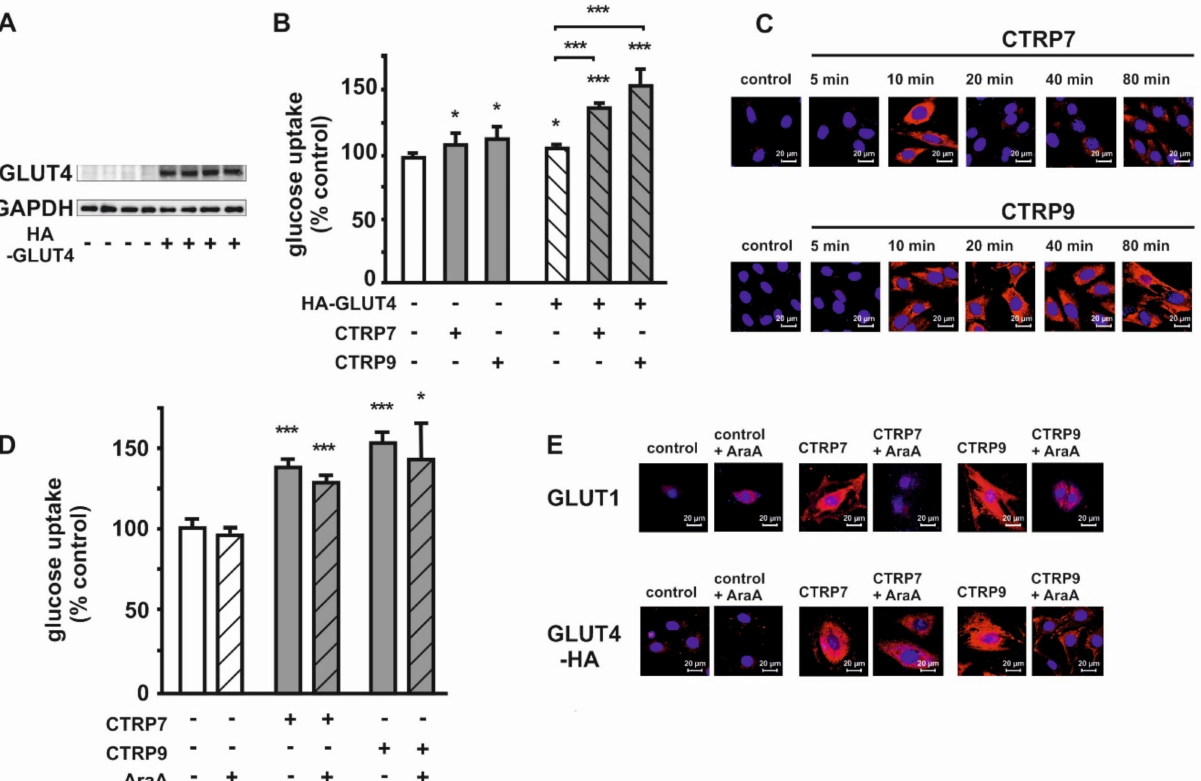
Figure 8. Effects of CTRP7 and CTRP9 on glucose uptake in GLUT4-overexpressing H9C2 cardiomyoblasts. ( A ) Western Blot identification of GLUT4 expression following GLUT4 overexpression compared to basal GLUT4 expression in H9C2 cells. GAPDH served as loading control. ( B ) Following glucose starving for 3 h in DMEM without glucose and serum, cells were treated with CTRPs in serum-free DMEM containing 2-[ 14 C] DG for 1 h. Value was normalized to protein concentration. Data are from 5 independent experiments with 3 biological replicates, each, and are represented as mean ± SEM. * p < 0.05, *** p < 0.001 vs. control, unless otherwise indicated. ( C ) Time course of GLUT4 translocation in response to CTRP7 or CTRP9, as detected with an anti-HA antibody. The nucleus was stained with TO-PRO™-3 Iodide. ( D ) Effects of AMPK inhibition with AraA (500 µ M) on CTRP7 and CTRP9 induced glucose uptake in H9C2 cells with GLUT4 overexpression. Data are presented as mean ± SEM of 5 independent experiments. * p < 0.05, *** p < 0.001 vs. control, unless otherwise indicated. ( E ) Effects of AMPK inhibition with AraA (500 µ M) on CTRP7- and CTRP9-induced GLUT1 and GLUT4 translocation. Images are representatives of 3 independent experiments showing similar